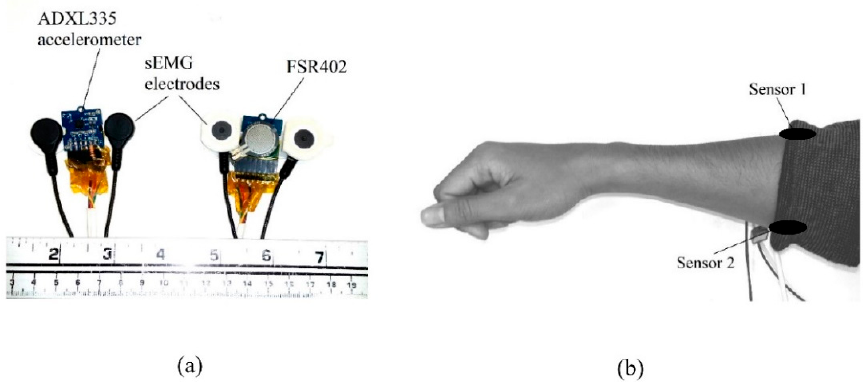
Figure 8. Setup to capture sample FMG, sEMG, and MMG signals. ( a ) FMG, sEMG, and MMG sensor ( b ) sensor placement.